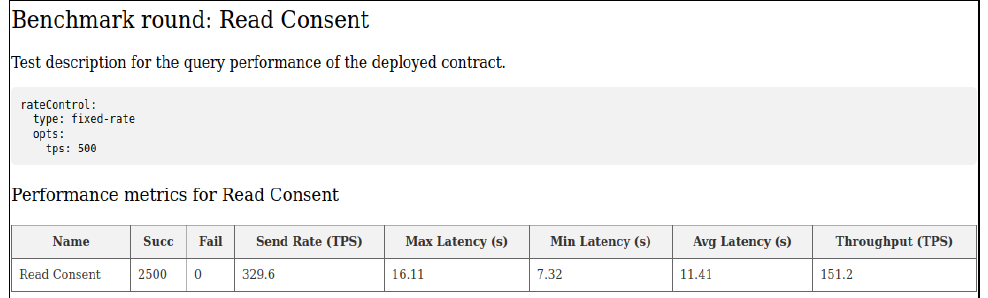
Figure 20. Caliper results (Read Consent) of experiment 3.